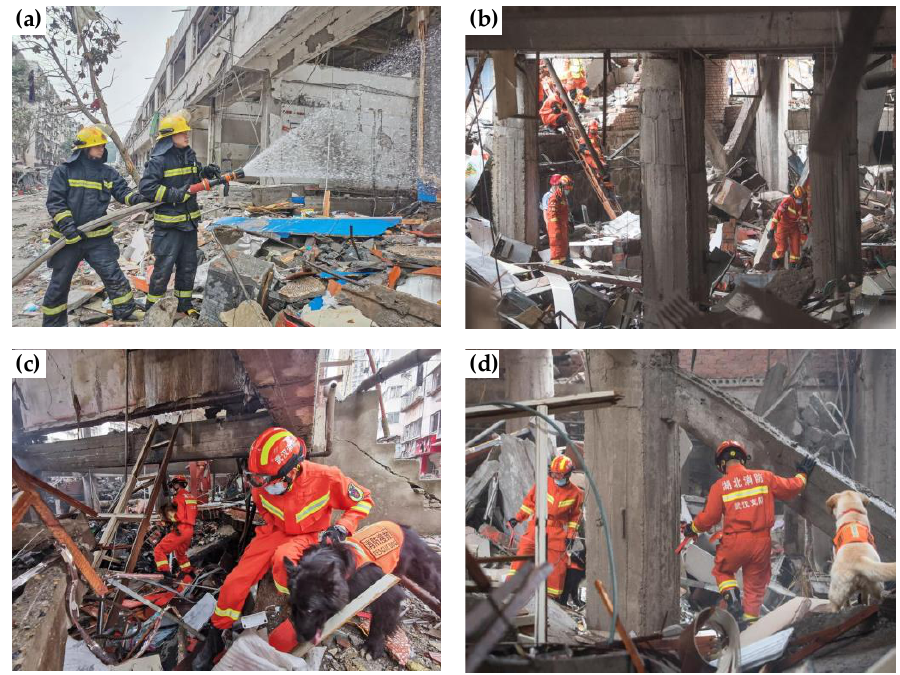
Figure 5. ( a – d ) Firefighters in search and rescue operation soon after the blast (Source: https://7news.com.au/news/disaster-and-emergency/at-least-12-dead-in-china-gas-explosion-c- 3098789, accessed on 14 August